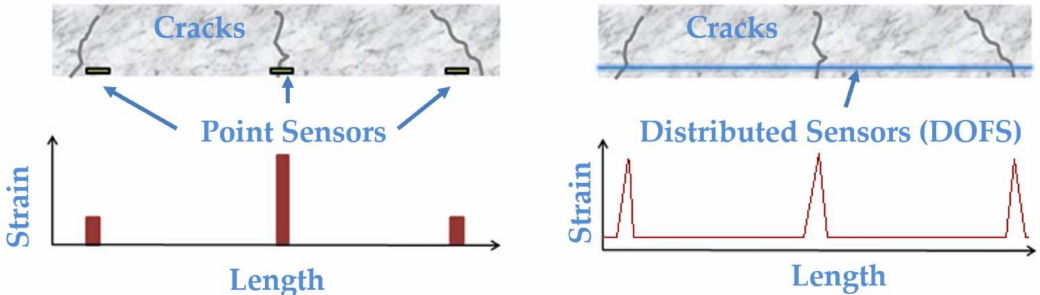
Figure 1. Spatial distribution detection with OFS ( left ) and DOFS ( right ).